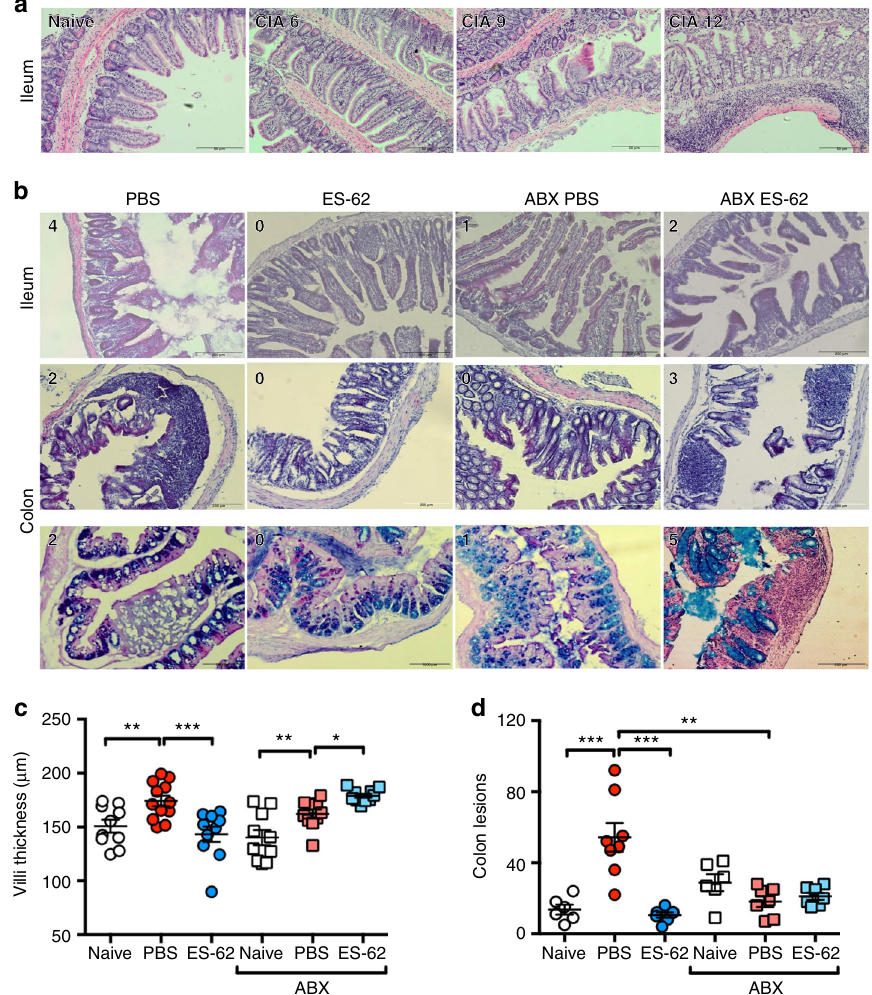
Fig. 4 CIA is accompanied by microbiome-dependent gut pathology. a Representative H&E images (scale bar representing 50 µ m) of ileum sections of Naive and PBS-CIA mice with differential disease severity at cull (mouse articular score as indicated). b Representative H&E images of ileum (top row), colon (middle row) and PAS-stained colon (bottom row) sections displaying scale bar (200 µ m) and articular scores of the mice are shown on the images. c Quantitative analysis of ileum villi thickness, where symbols represent mean values of replicate sections as measured using ImageJ analysis software ( n = 3/group with 3 – 5 replicates/animal and data are from two independent experiments). d Lesions were enumerated per colon section of individual mice using ImageJ imaging software (Naive; n = 6, PBS; n = 8, ES-62; n = 7, Naive + ABX; n = 6, PBS + ABX; n = 7, ES-62 + ABX; n = 7). Statistics: data are pooled from two independent experiments. Statistical signi fi cance was determined using one-way ANOVA with LSD Fishers multiple comparisons